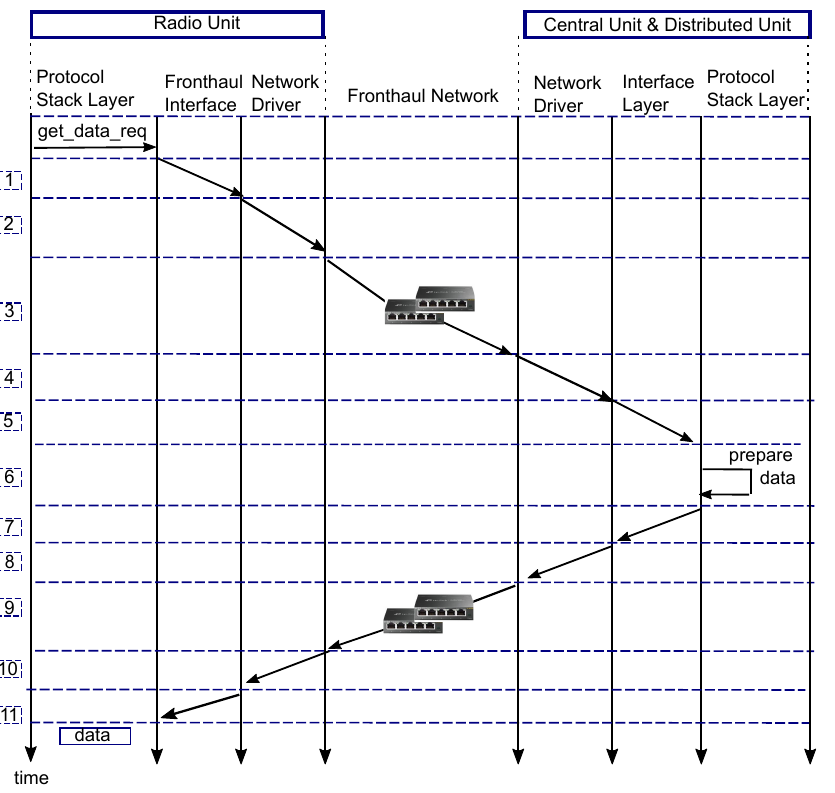
Figure 3. Representation of the round trip time measurement.